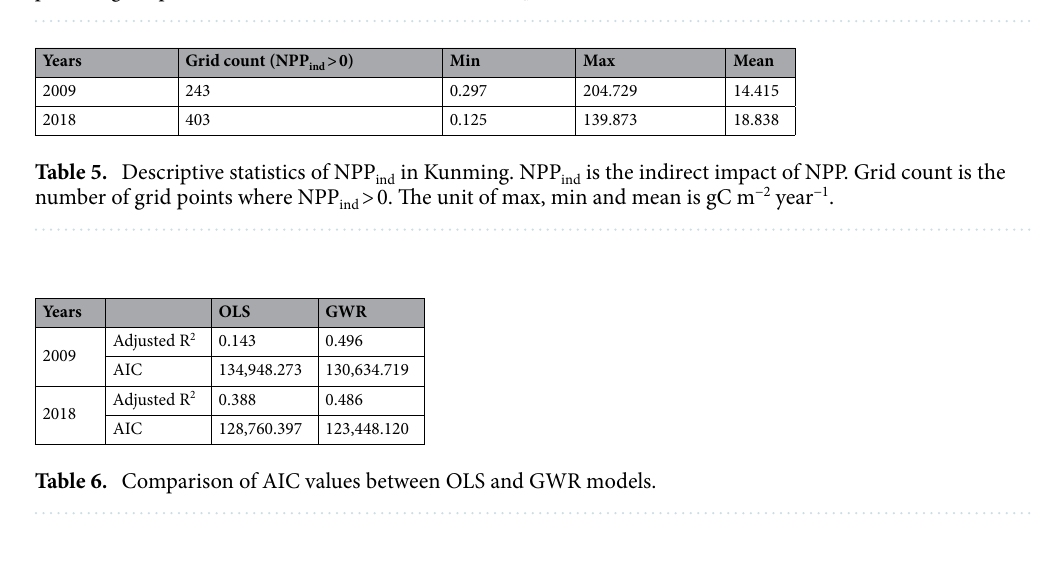
Figure 3. Percentage of positive and negative correlation of LST on NPP ind in Kunming city. The orange column represents percentage of positive correlation area of LST on NPP ind in total area. The blue column represents percentage of positive correlation area of LST on NPP ind in total area.